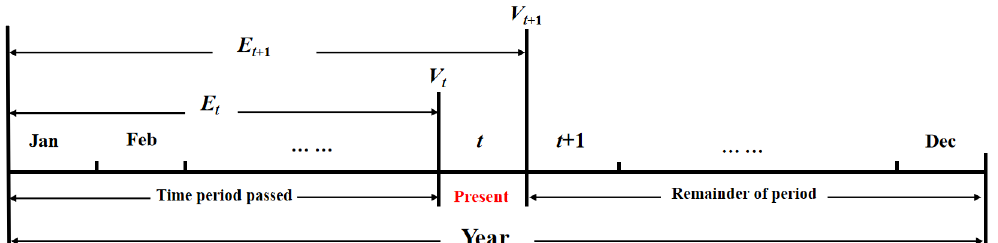
Figure 4. Division of time periods for dynamic programming